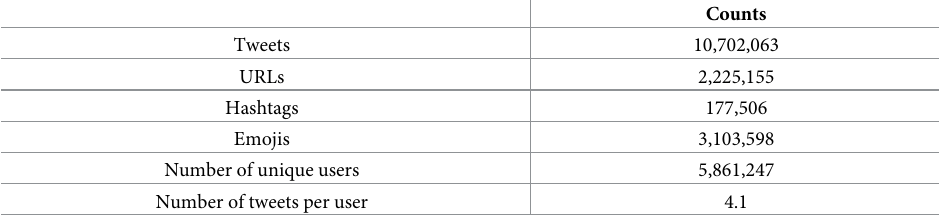
Table 1. Information on the data corpus collected before